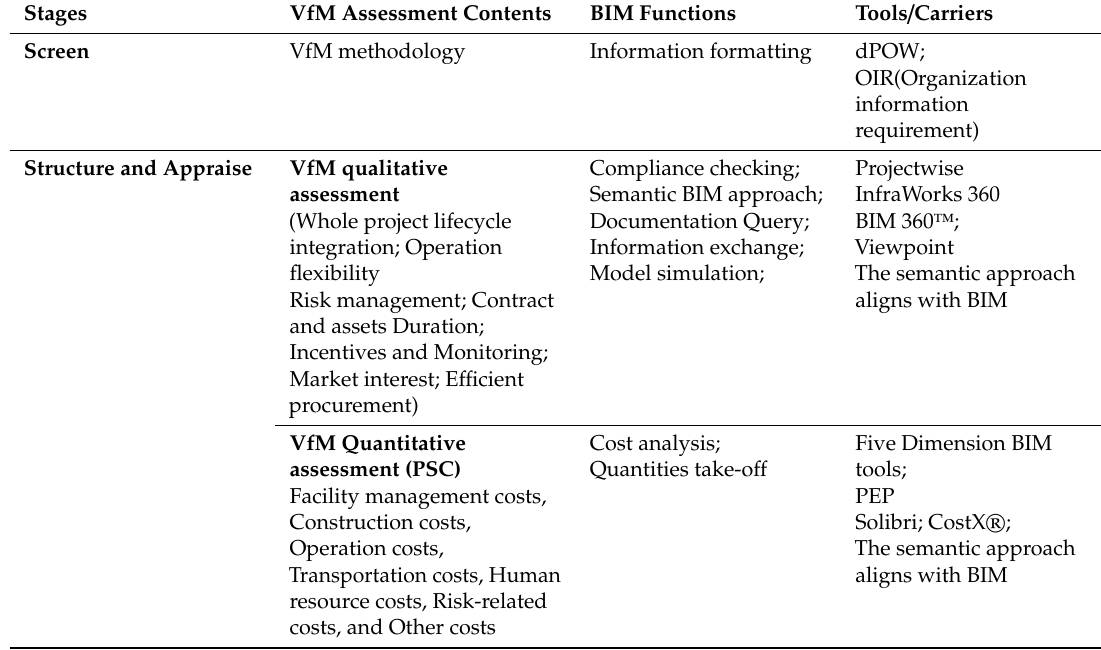
Table 7. VfM indicators and corresponding BIM function resources could potentially maximise the benefits along the entire project lifecycle. PEP: project execution plan, dPOW: a digital plan of work, and PSC: public-sector